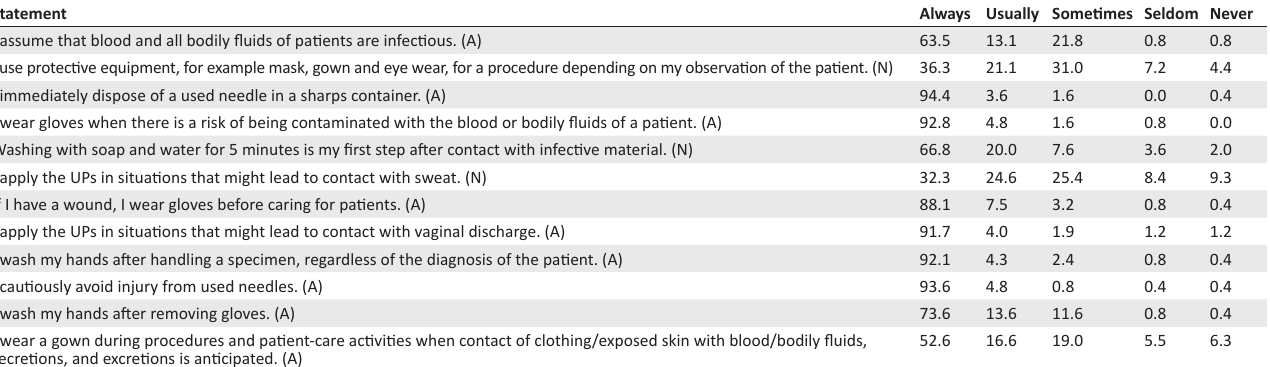
TABLE 4: Practice of the UPs ( % ).